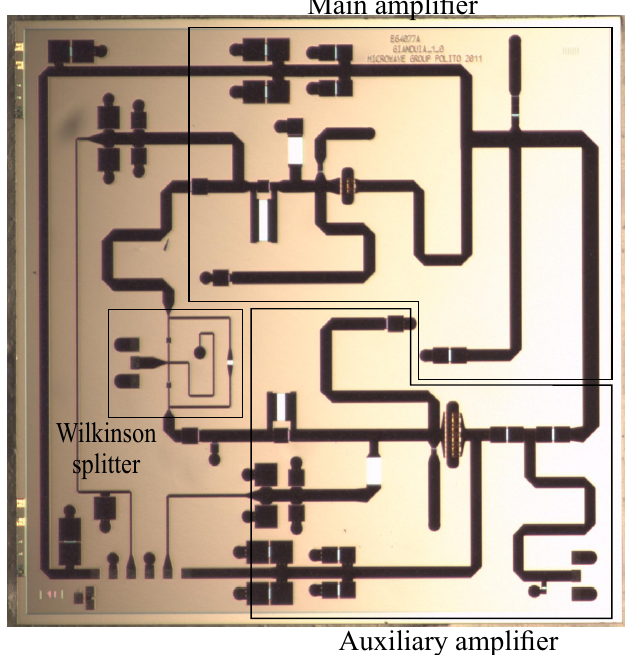
Figure 3. Microscope picture of the Doherty PA MMIC fabricated with the TriQuint foundry process, first generation. The building blocks are